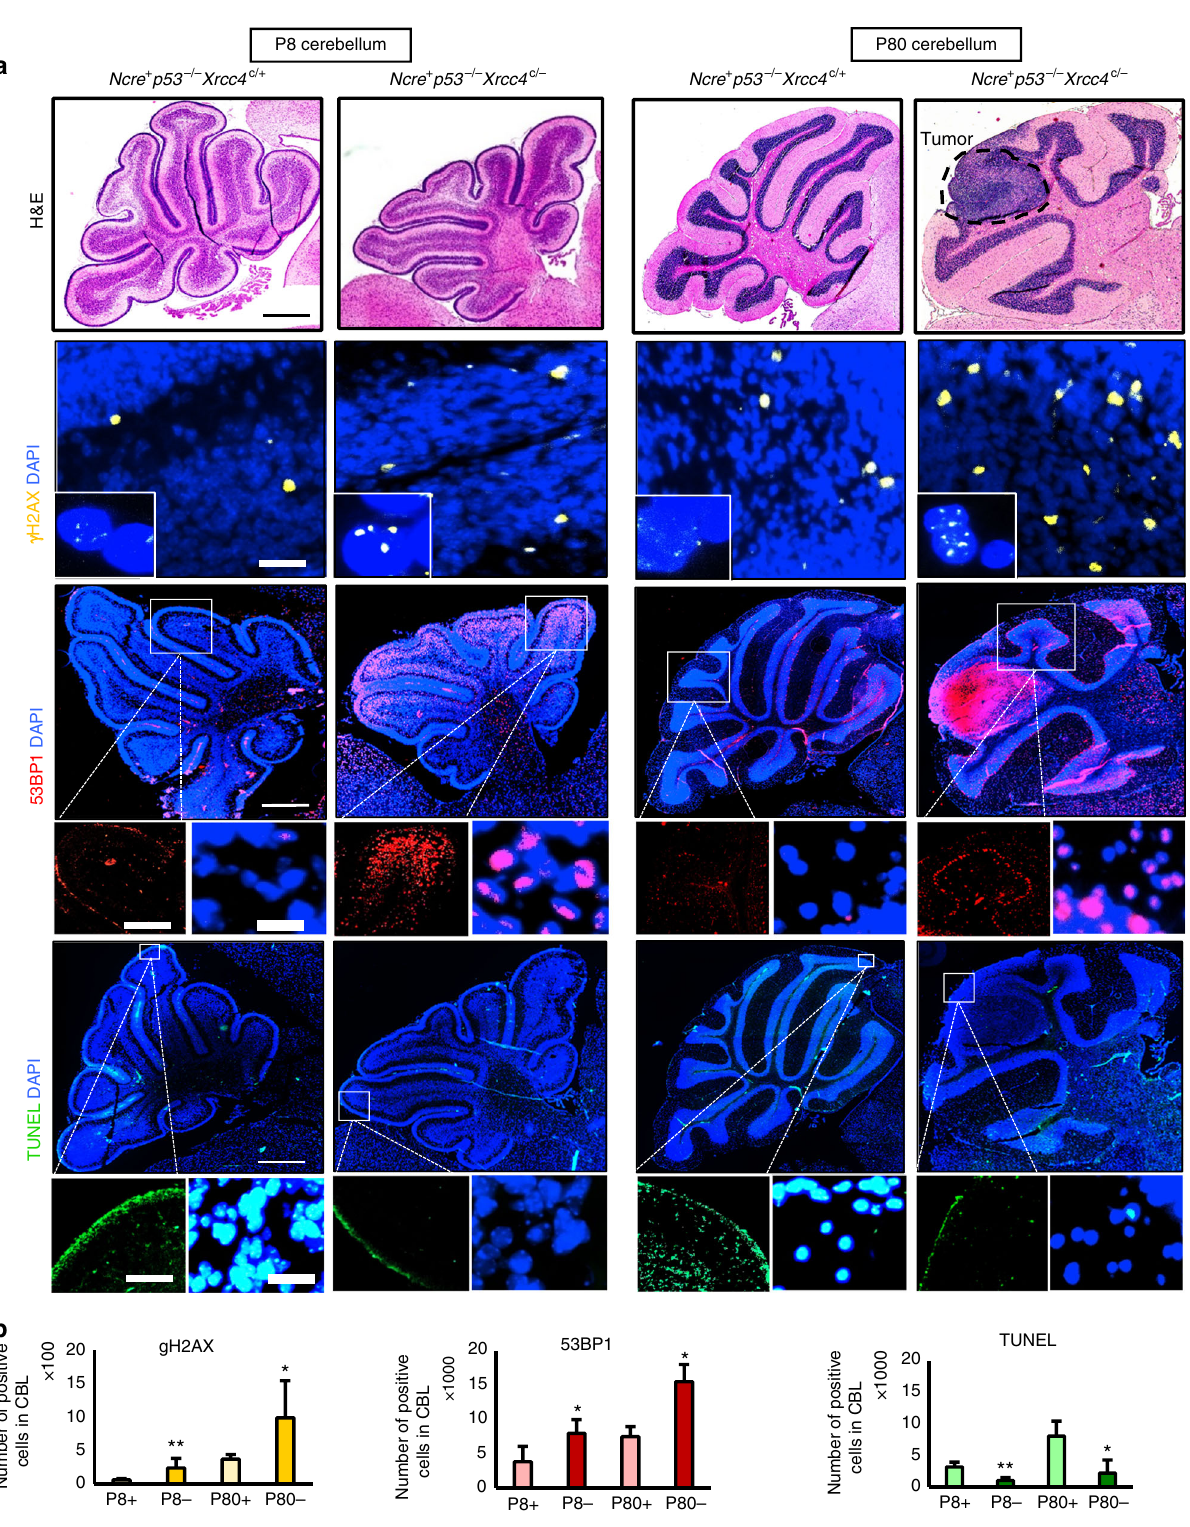
Fig. 3 Analysis of brain tissue from early postnatal stages (P8) up to tumor formation (P80) in XRCC4/p53-de fi cient mice ( Nestin-cre p53 − / − Xrcc4 c/ − ) and control animals ( Nestin-cre p53 − / − Xrcc4 c/ + ). a Upper panels, H&E staining of cerebellum sections shows the location of the tumor at P80 (magni fi cation, ×100). Middle and lower panels, representative immuno fl uorescence stainings for DSB markers gH2AX and 53BP1 and for terminal deoxynucleotidyl transferase (TdT)-mediated dUTP nick end labeling (magni fi cation, ×100; insets, ×200, and ×600). Representative images for 11 analyzed cerebella are shown. Analysis of brain sections at intermediate stages (P60) are shown in Supplementary Figure 5. b Quanti fi cation of the number of cells positive for gH2AX, 53BP1, and TUNEL, respectively. CBL cerebellum; p8 + , p53 − / − Xrcc4 c/ + , p8 − , p53 − / − Xrcc4 c/ − . Between 4 and 12 sections per animal were analyzed, with 8 animals in the XRCC4-de fi cient group and 3 animals in the XRCC4-pro fi cient group). Unpaired t -tests were done to test for signi fi